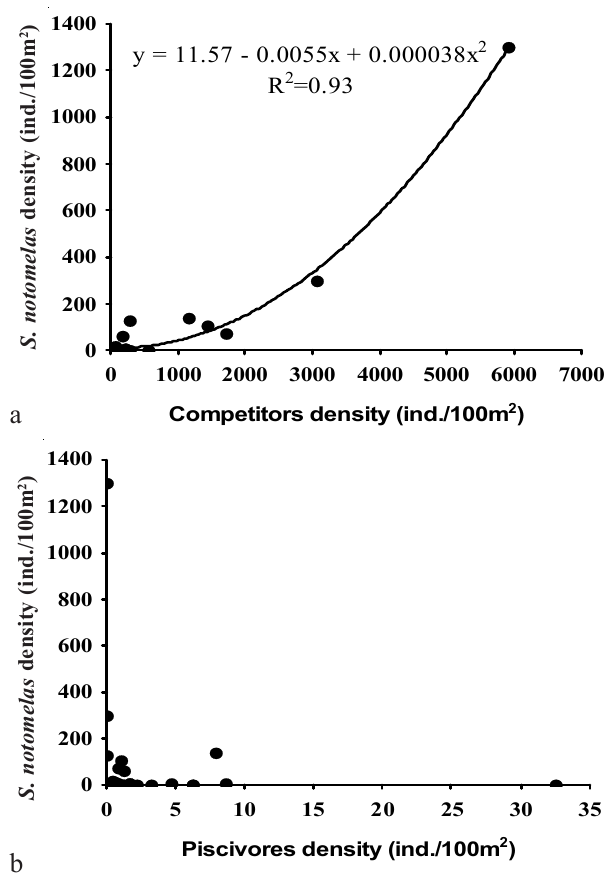
Figs. 4a-b. Relationship between densities of Serrapinnus notomelas and densities of competitors (a) and piscivores (b).